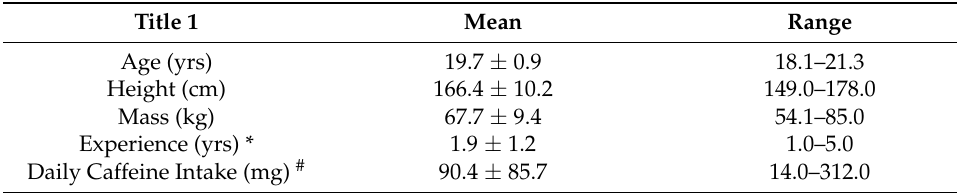
Table 1. Participant